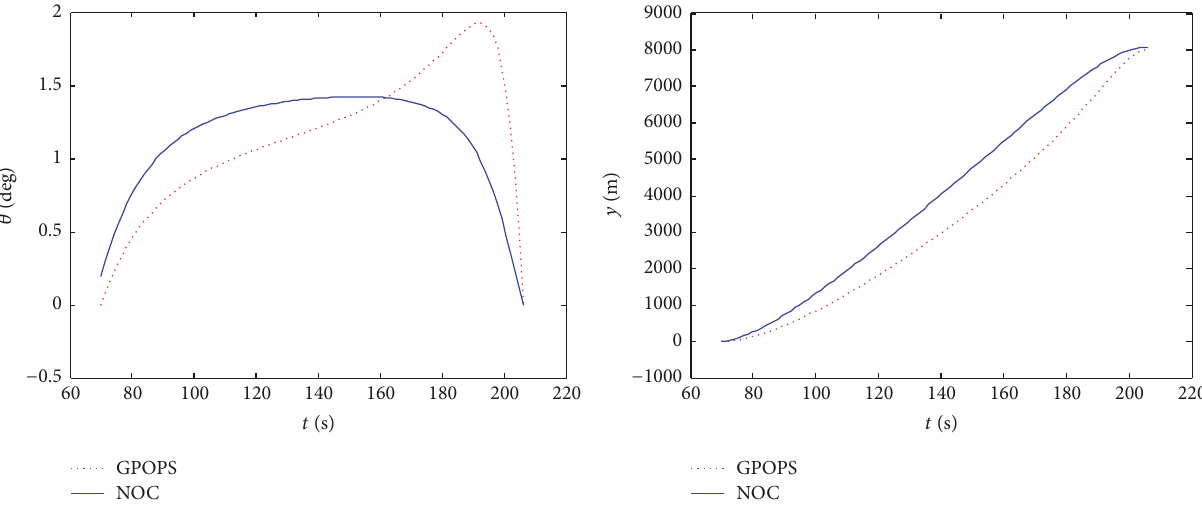
Figure 9: Curves of modifications with altitude increasing 8000